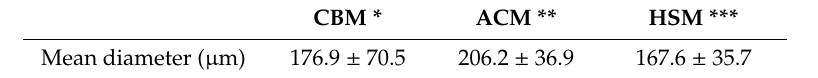
Figure 2. Size distributions of corn stover pulverized by the ( a ) continuous ball mill; ( b ) air classifier mill; and ( c ) high-speed mill. The bars indicate standard deviation. Table 1. Mean diameters of pretreated corn stovers, depending on the pulverizer used.